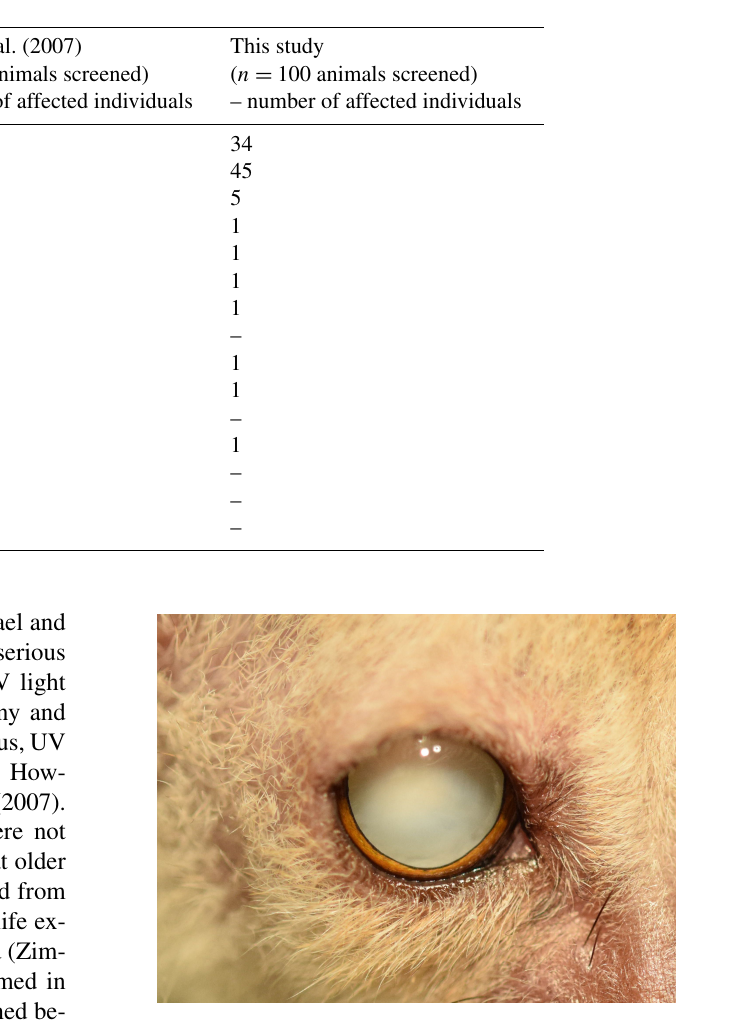
Table 1. Summary of all published ocular findings from mouse lemur colonies.